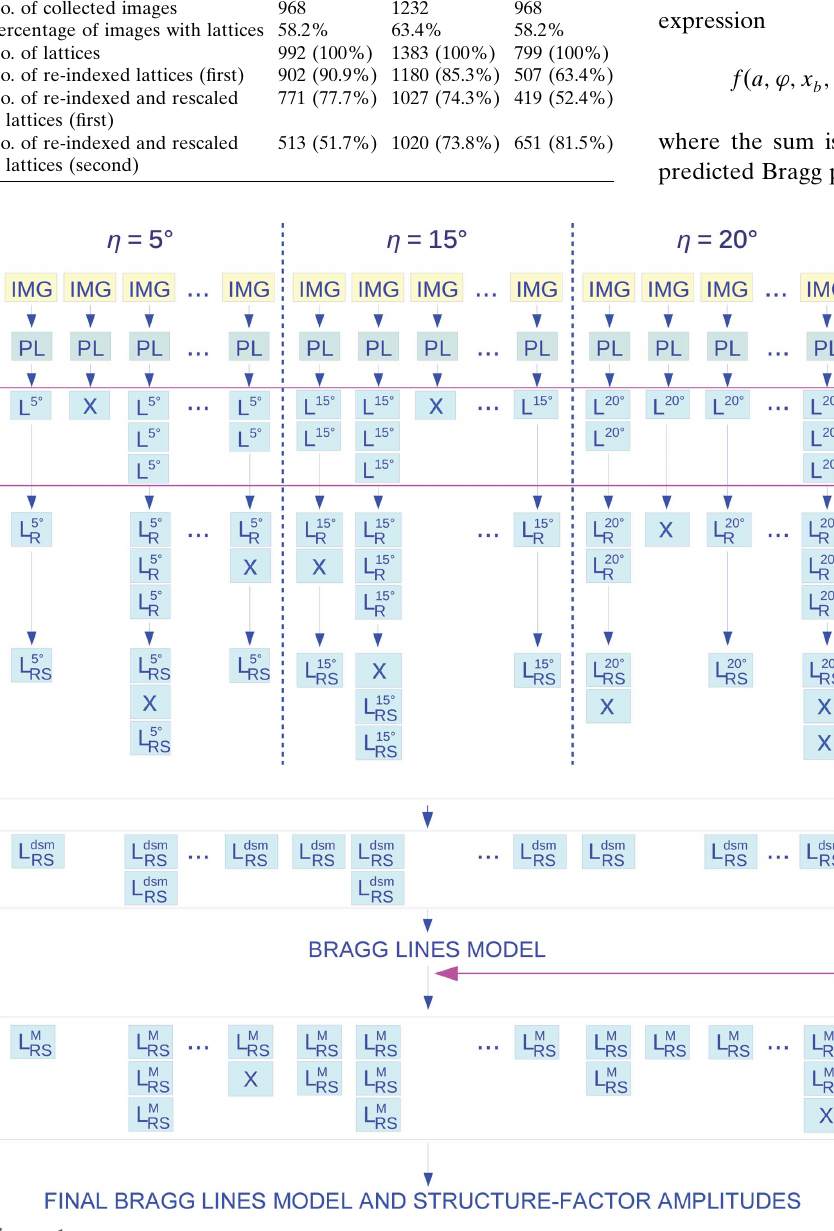
Figure 1 Data-analysis protocol. Abbreviations: IMG, diffraction image; PL, peak list; L, lattice; X, discarded; R, re-indexed; S, scaled; dsm, after data-set merging; M, model. Step 1, extraction of a list of high-intensity peaks from each diffraction image. Step 2, lattice identification and refinement, spot search on the images, refinement of parameters and spot integration. Step 3, indexing-ambiguity solution within each data set. Step 4, scaling of intensities within each data set. Step 5, indexing-ambiguity solution and scaling between different data sets. Step 6, data merging and modeling of intensities along Bragg lines. Step 7, indexing- ambiguity solution and scaling of lattices determined in Step 2 using the intensity model as a reference. Step 8, data merging and fitting to obtain the final intensity model and structure-factor amplitude extraction.